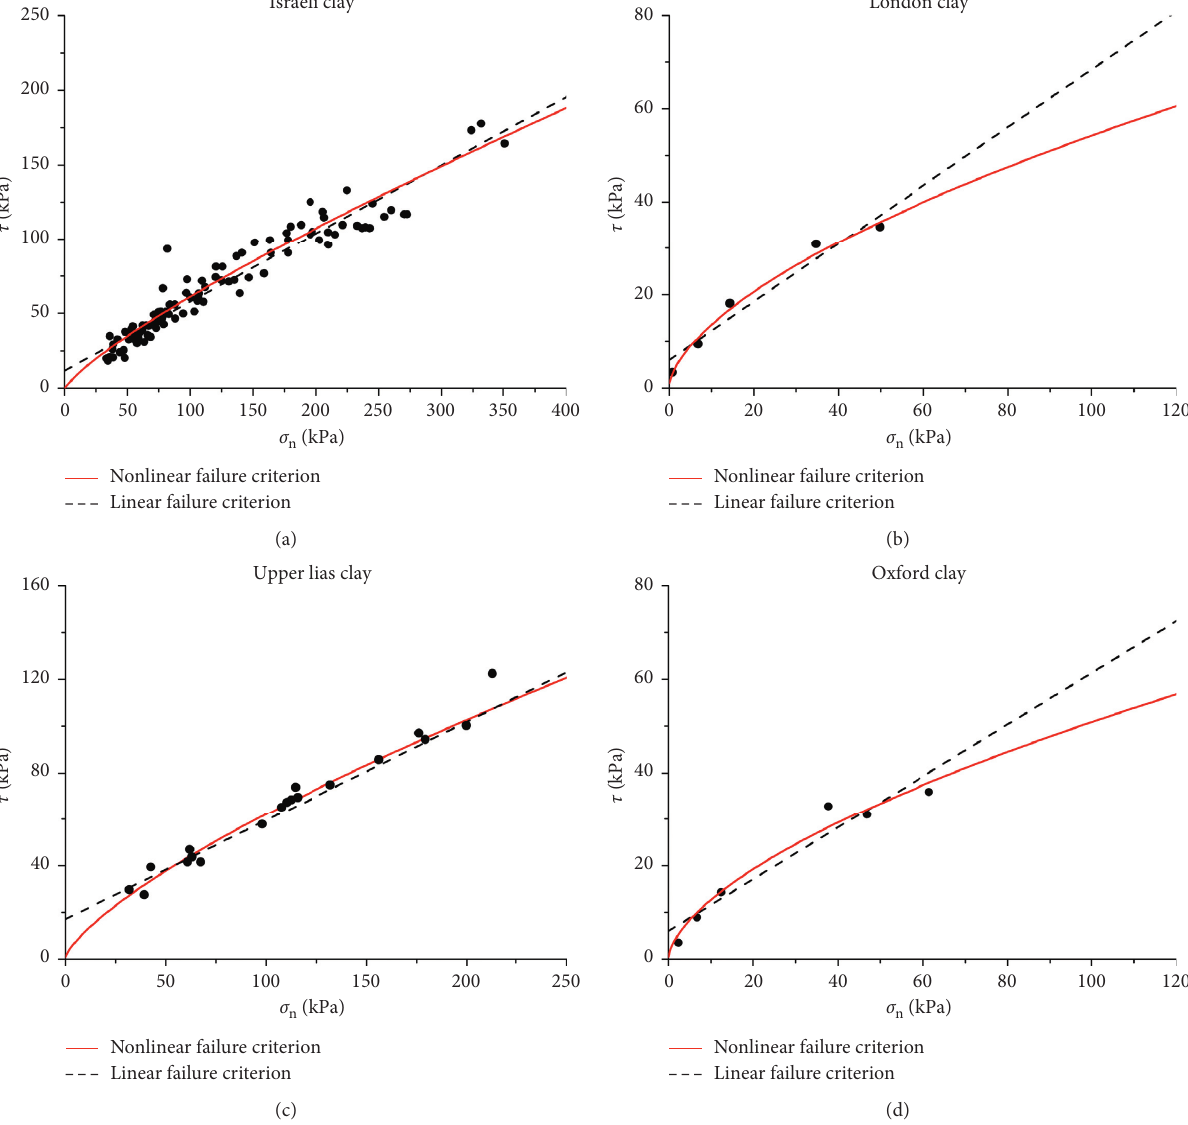
Figure 6: Experiment data and two failure criteria for four clays. (a) Israeli clay. (b) London clay. (c) Upper Lias clay. (d) Oxford